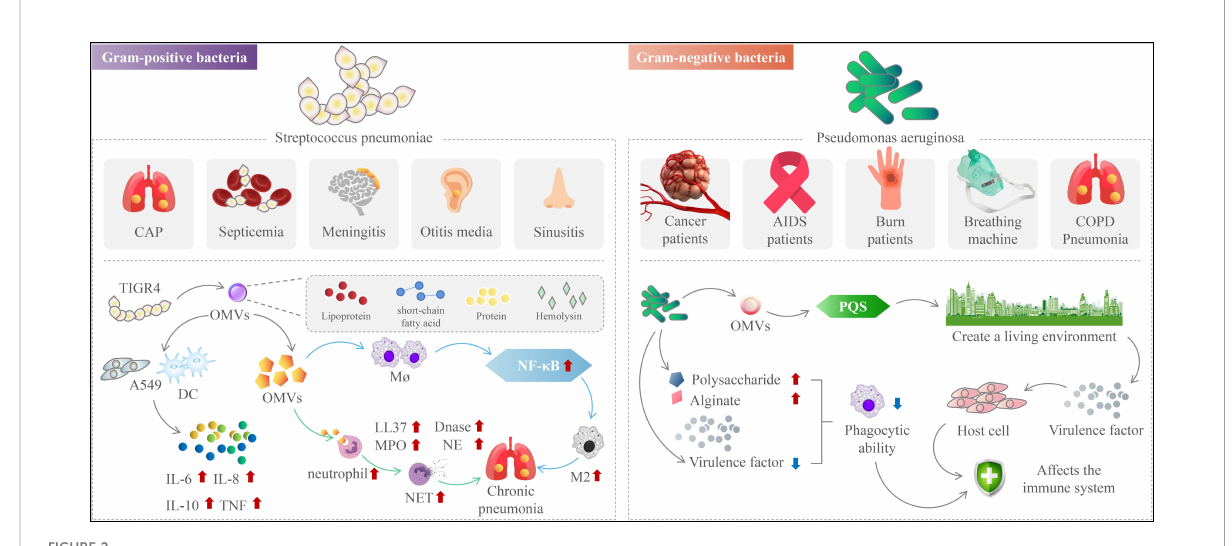
FIGURE 2 The mechanism of action of outer membrane vesicles in chronic respiratory